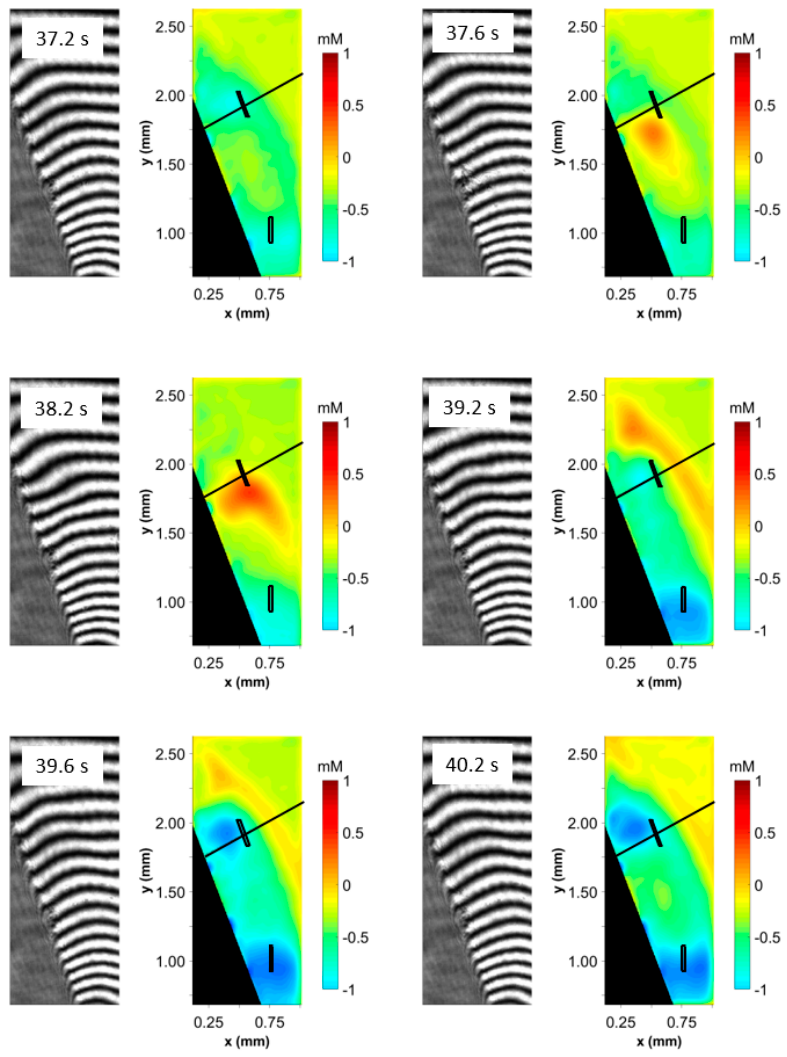
Figure 7. Copper electrodeposition on Fe cone (45 ◦ ): interferogram and variation in the concentration of CuSO 4 for the instants corresponding to t = 37.2, 37.6, 38.2, 39.2, 39.6, 40.2 s. The bulk concentration of CuSO 4 is 300 mM, J = 8 mA/cm 2 .